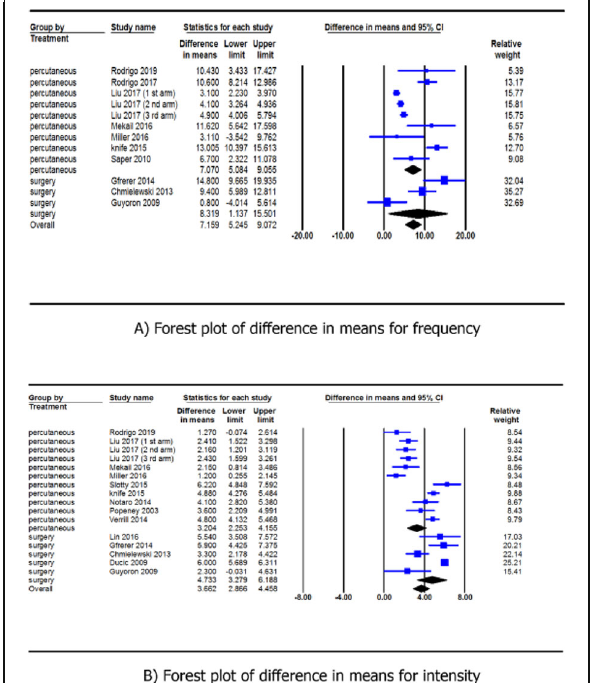
Fig. 1 (abstract P0487). See text for description